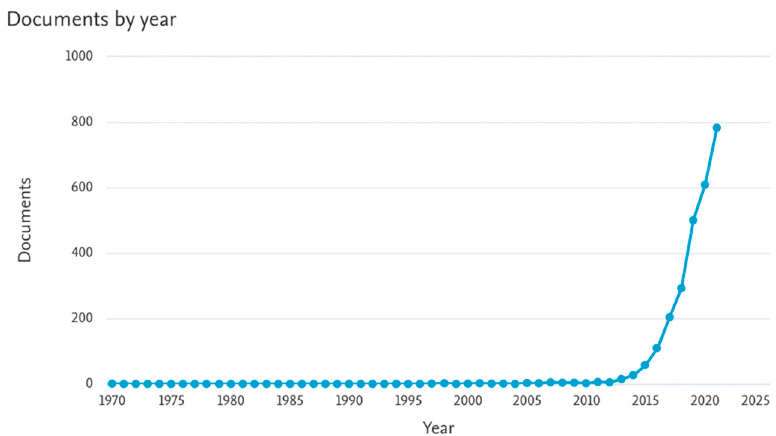
Figure 1. Analyze search results by keywords: ‘PLA printing’ in 2000–2021 [64].